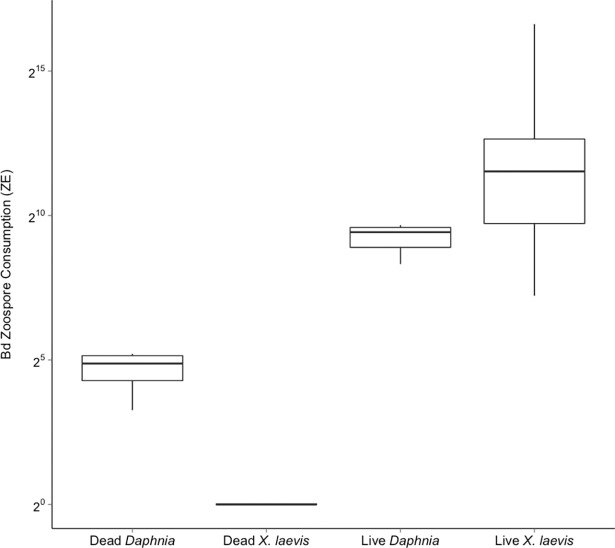
Bd zoospore consumption by X. laevis and Daphnia.Average number of Bd zoospores found in the guts of X. laevis or on/in the entire three Daphnia after 4.5 hours of exposure to 442,000 zoospores. The zoospore values were log transformed to normalize the range of Bd zoospore values. All treatment groups were significantly different from each other (Permutation ANOVA: DF = 3, iterations = 5,000, p = <0.01; FDR p-value adjustments, p<0.05).